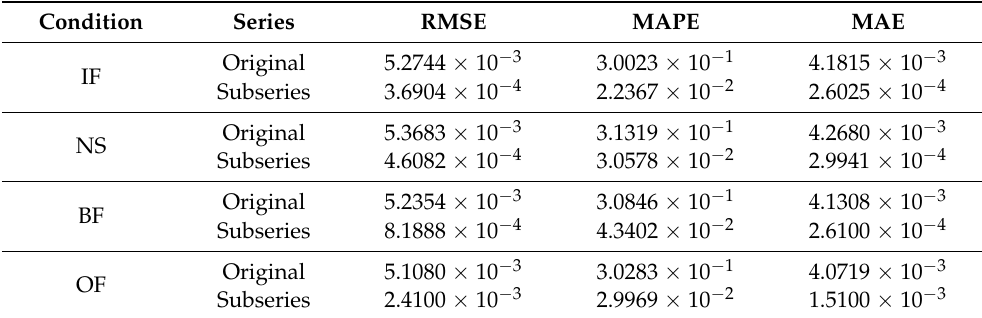
Table 4. Comparison of performance criteria of ARMA-ANN model for the original series and subseries.